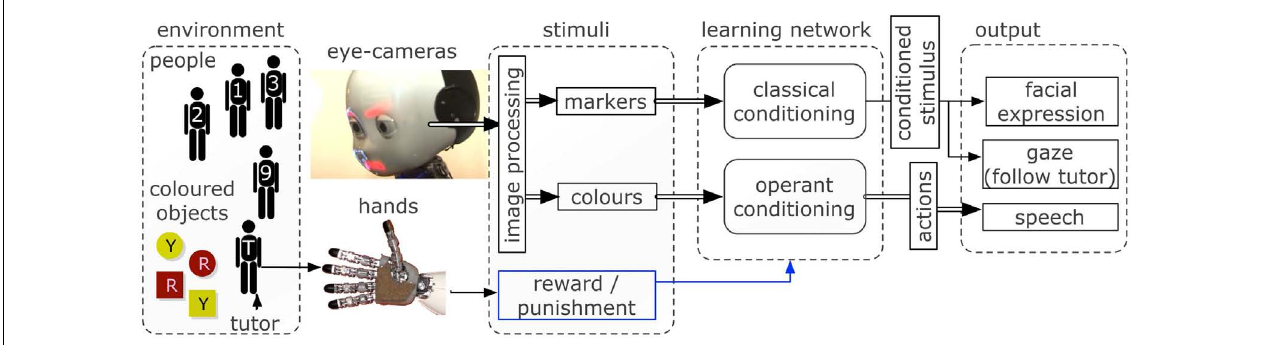
vectorized representation to the network.The control network triggers facial expressions, gazing behavior, and speech output depending on the neural